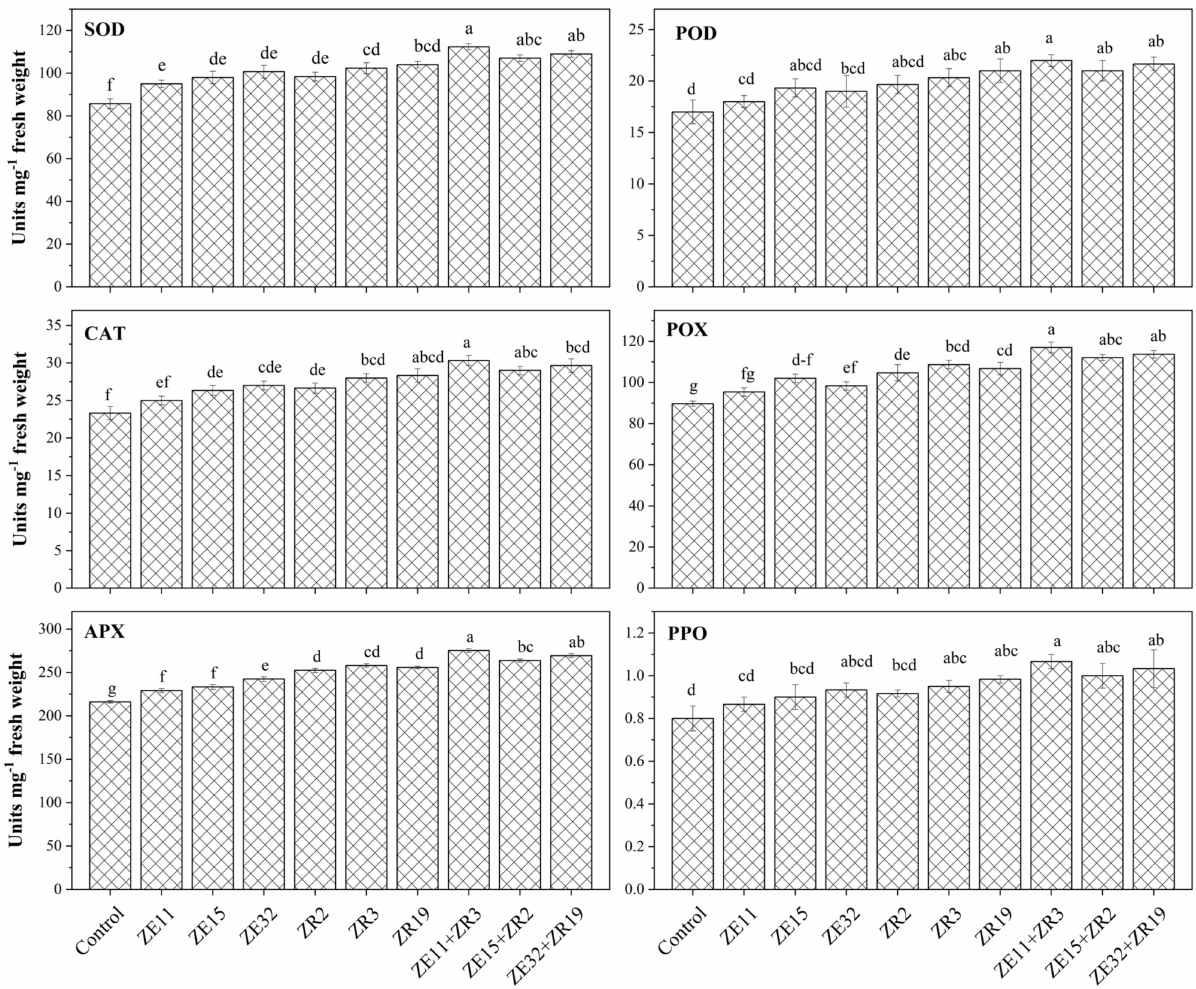
Figure 2. Influence of Bacillus and Paenibacillus species on antioxidative status of wheat. Data are presented as mean of three replicates. Bars followed by same letter(s) are not significantly different according to least significance difference (LSD) test at p ≤ 0.05. PPO, polyphenol peroxidase activity; POD, peroxidase dismutase activity; SOD, superoxide dismutase activity; CAT, catalase activity; APX, ascorbate peroxidase activity; POX, peroxidase